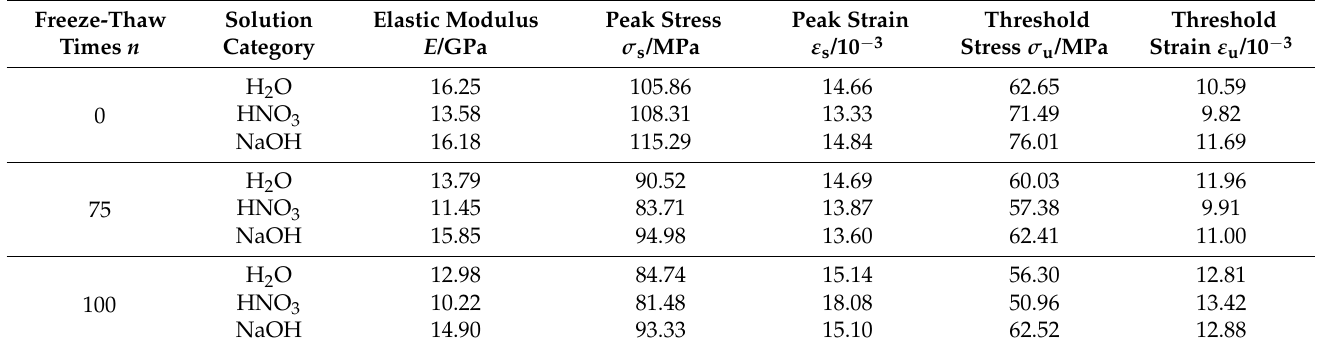
Table 2. Uniaxialtest data for different chemical solutions and freeze-thaw